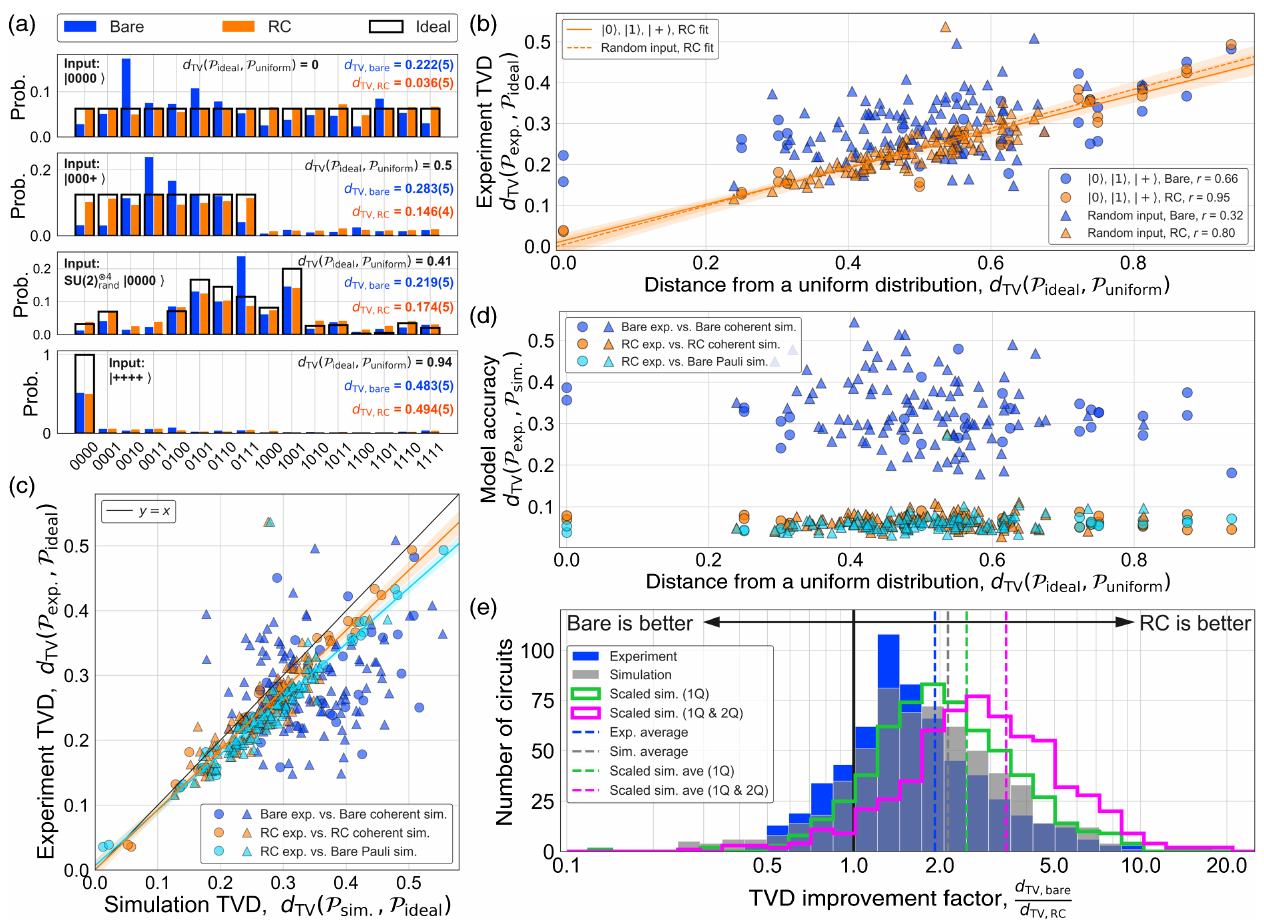
FIG. 3. Improving the quantum Fourier transform with randomized compiling. (a) Measured probability distributions for the QFT applied to j 0000 i , j 000 þi , jþ þ þþi , and a random input state [ SU ð 2 Þ ⊗ 4 j 0000 i ]. (b) Bare and RC TVDs for all four-qubit QFT results, rand as a function of distribution uniformity of the ideal results. RC provides more improvement as the resultant distribution spans more basis P ; P → 0 ]. Circles indicate the QFT applied to Pauli basis states ( fj 0 i , j 1 i , jþig ), and triangles indicate random states [ d TV ð ideal uniform Þ inputs states [ SU ð 2 Þ ⊗ 4 j 0000 i ]; we use the same distinction in panels (c) and (d), but omit the description in the legend for clarity. rand Pearson r values listed in the legend quantify the correlation strength of each data set, justifying linear fits for the RC data (transparent bands indicate the 95% confidence intervals). (c) Experimental vs simulated TVDs from two models based on the Pauli error rates in Fig. 2(b). The blue (orange) markers denote the bare (RC) circuits simulated with the coherent error model, and the cyan markers denote the bare circuits simulated with the Pauli model. (d) Accuracy of the two models compared to experimental results. The bare circuits simulated with the Pauli model are plotted against the experimental RC results in panel (c), which are also used to compute the model accuracy in panel (d). (e) Summary of the improvement under RC for all two-, three-, and four-qubit random input QFT results, showing good agreement between experiment (blue) and theory (gray). Simulations in which single-qubit (green) and two-qubit (pink) error rates have been scaled down by a factor of 10 suggest that RC performance increases as error rates decrease. (Error bars on the TVD [ O ð 10 − 3 Þ ] for panels (b) – (d) are smaller than the